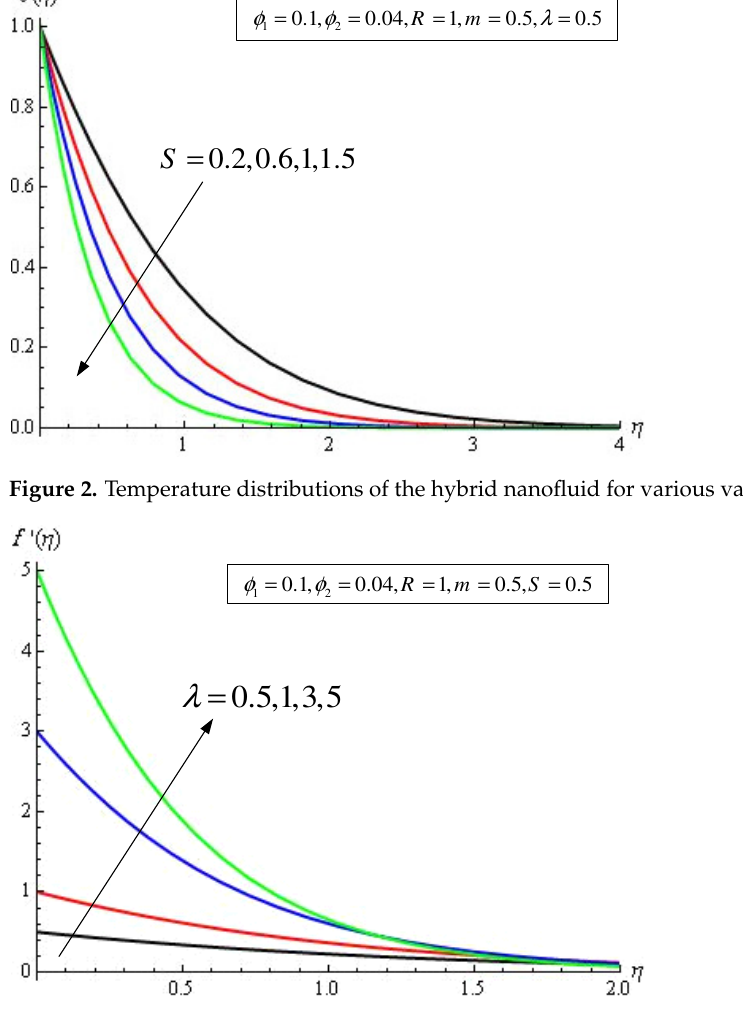
Figure 3. Velocity profiles f (cid:48) ( η ) for various values of λ